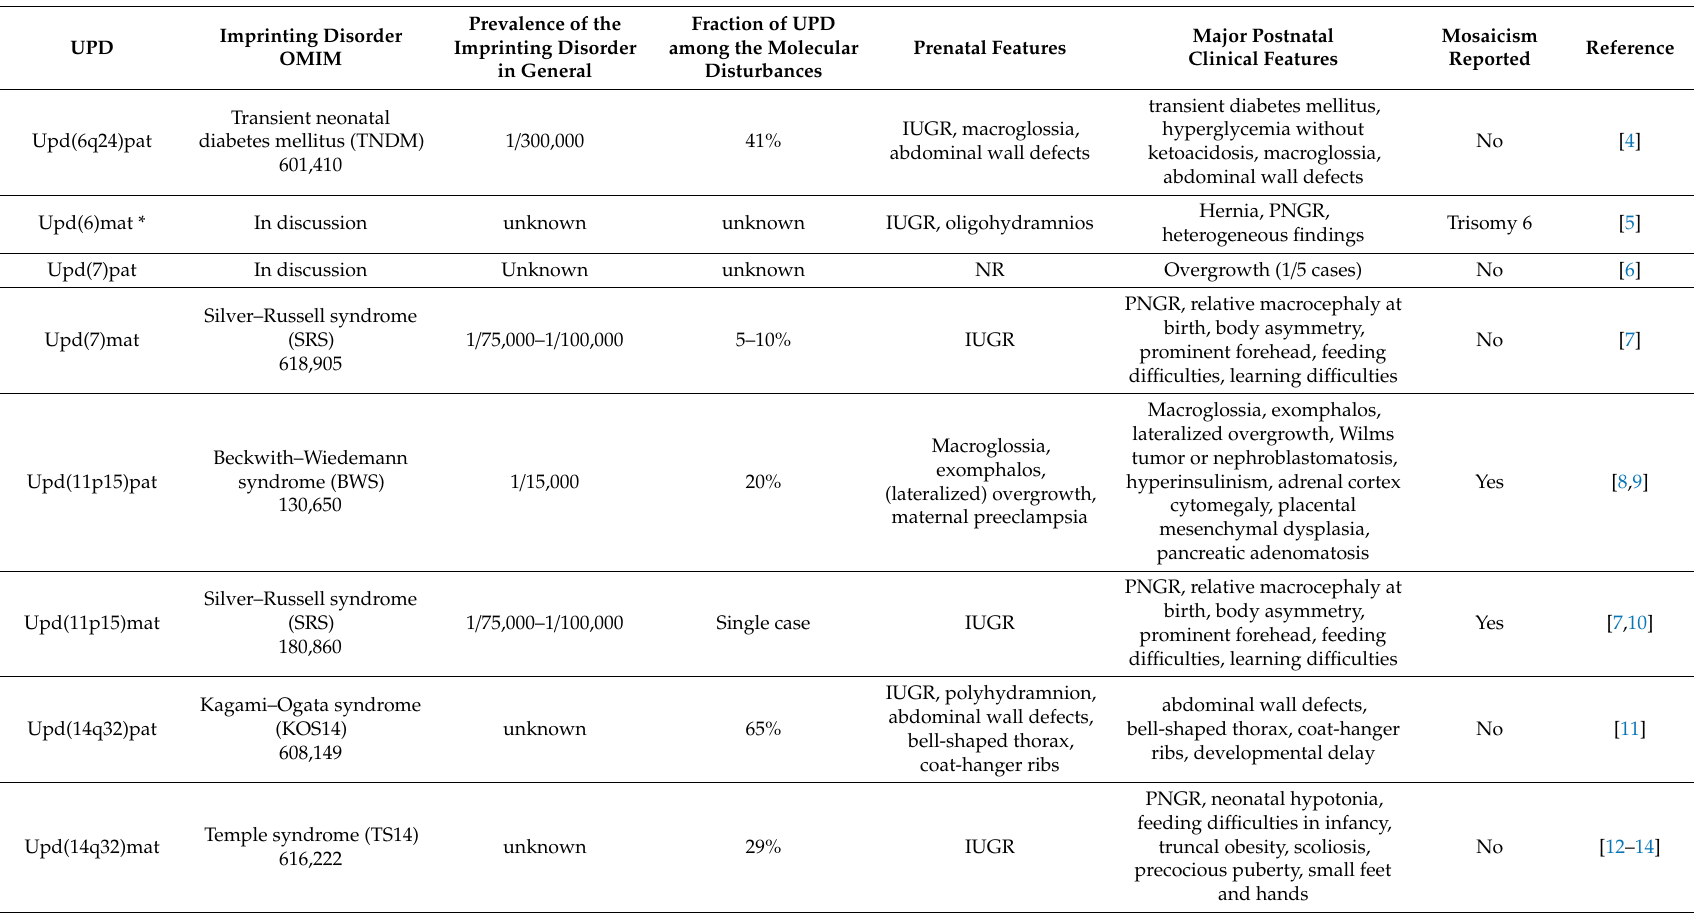
Table 1. Uniparental disomies (UPDs) for which an association with congenital disorders is known or